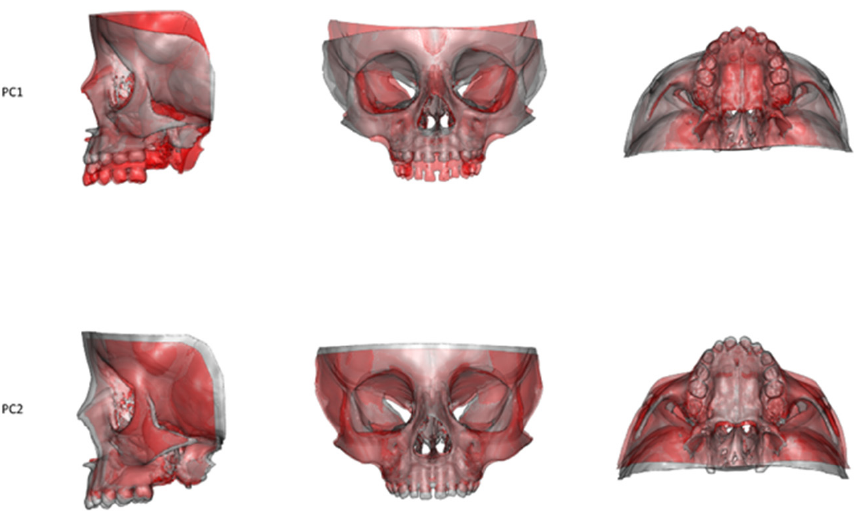
Figure 7. Surface warpings of the maximum and minimum PC1 ( top ) and PC2 ( below ) scores along the symmetric PCA. The grey surface indicates minimum (negative) values while the red surface indicates maximum (positive) values along the PCA axes.